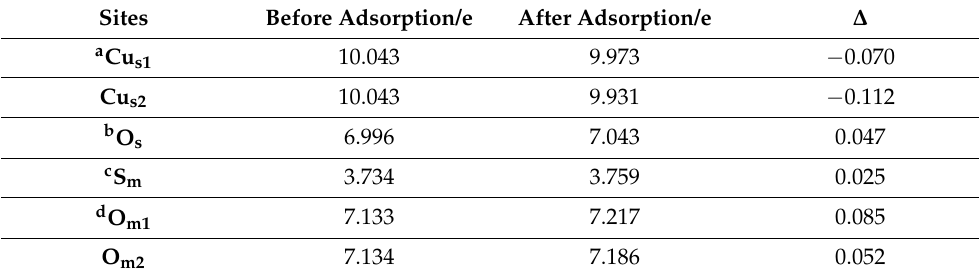
Table 2. Bader charge of the SO 2 adsorption over the CuO surface (111).